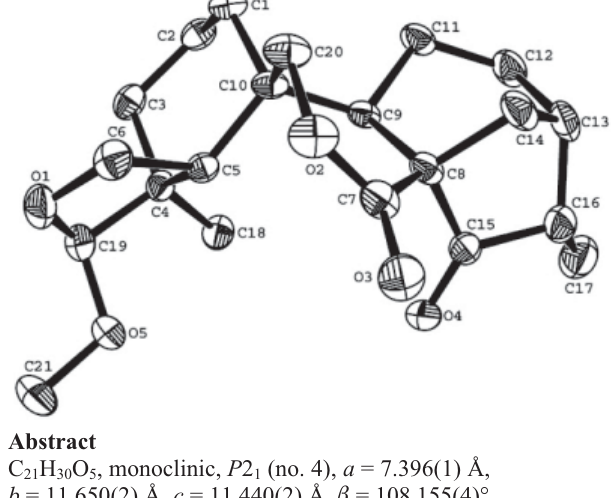
Table 2. Atomic coordinates and displacement parameters (in Å 2 )